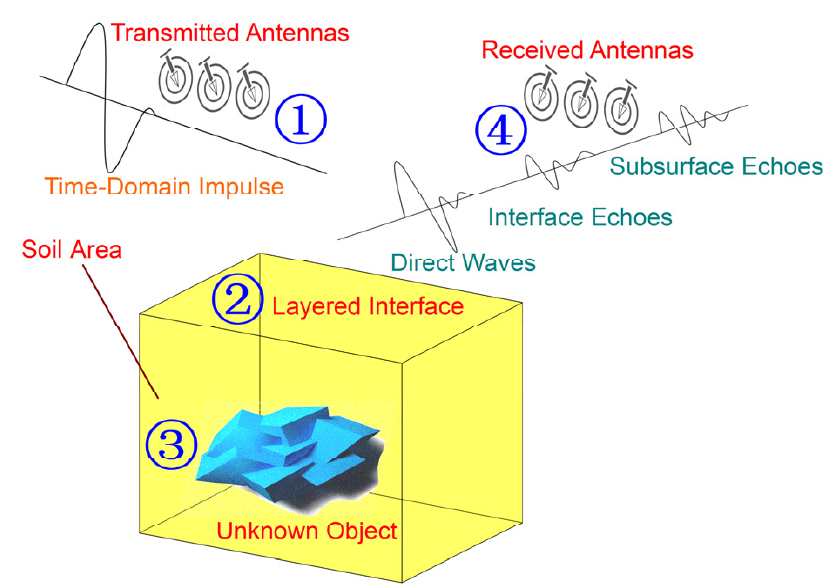
Figure 1. Collections process for measured data in the soil area.